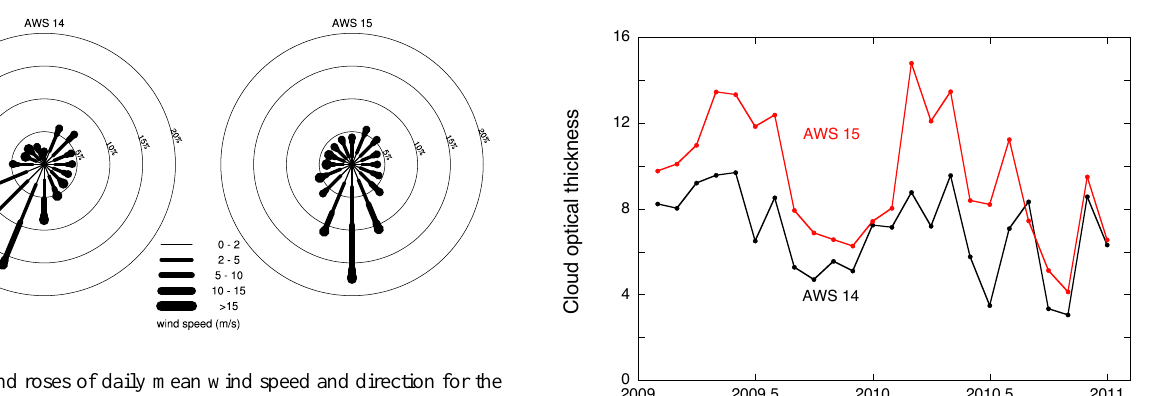
Fig. 4. Wind roses of daily mean wind speed and direction for the period 1 February 2009–31 January 2011, for AWS 14 (left) and 15 (right). The percentages refer to the frequency of occurence.